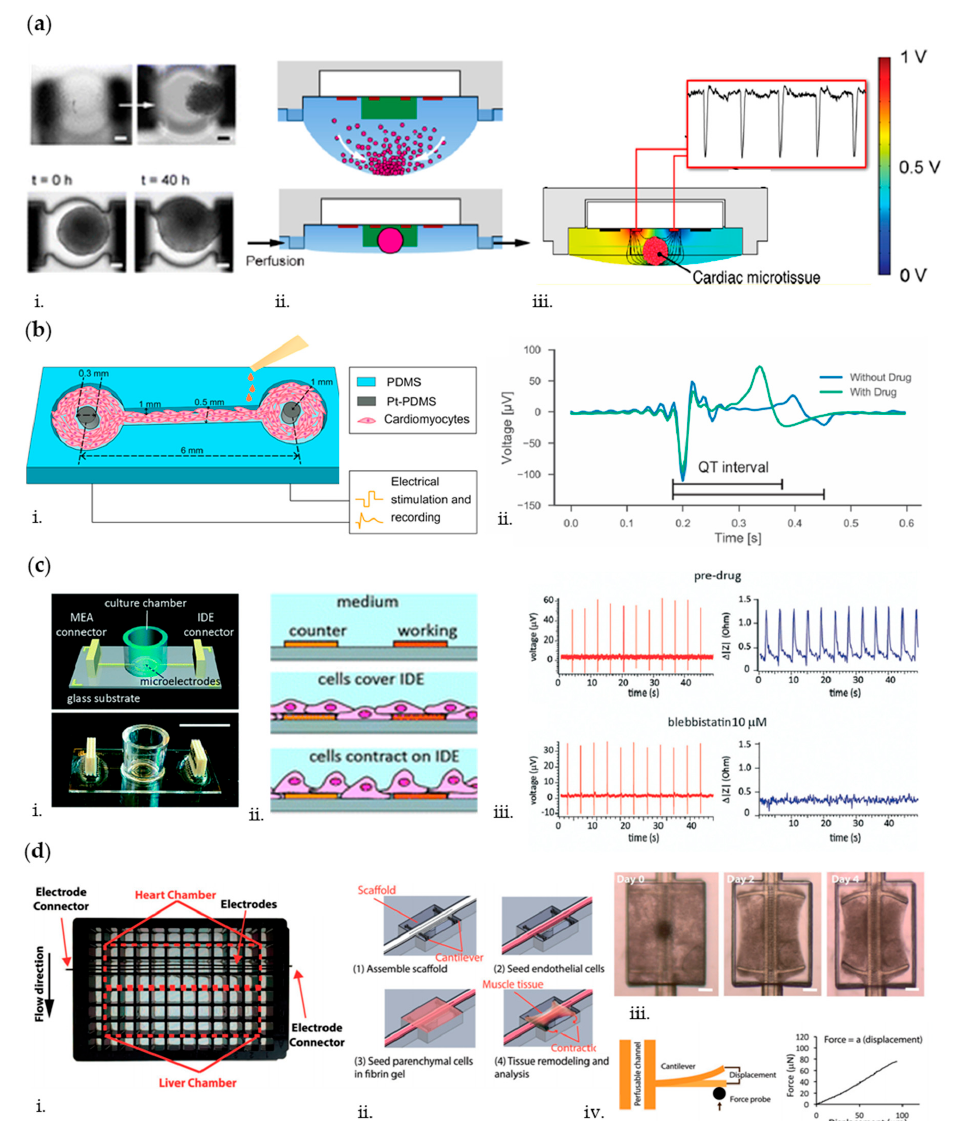
Figure 7. ( a ) Schematic (ii) of on-chip spheroid formation in the hanging drop and subsequent growth monitoring in low-height hanging drops including images at different time points (scale bars are 100 µm, i). Schematic modeling of the tissue-evoked impedance changes in hanging drops network (iii). Adapted from Ref. [163] with permission from ACS Publications. ( b ) Schematic of the 3D Pt-PDMS pillar electrode platform for cardiac tissues (i); 100 nM of the drug isoproterenol was tested on the myocardium indicating clear changes in the QT interval (ii). Adapted from Ref. [52] with permission from Elsevier. ( c ) Schematic and picture of the interdigitated electrodes (IDE)-based chip (i). Scale bar is 1 cm. Schematic of tissue growth and contraction on the IDE (ii) and platform validated with 10 µM blebbistatin: field potentials (MEA, red) and contraction (IDE, blue) data recorded on the same device before and after drug application (iii). Adapted from Ref. [171] with permission from The Royal Society of Chemistry. ( d ) Image of the scaffold multiwall plate including heart chambers (i). A pair of carbon electrodes was embedded into the base plate adjacent to the heart chamber for electrical stimulation. Schematics of the cell seeding process (ii). Brightfield images of the cardiac tissue